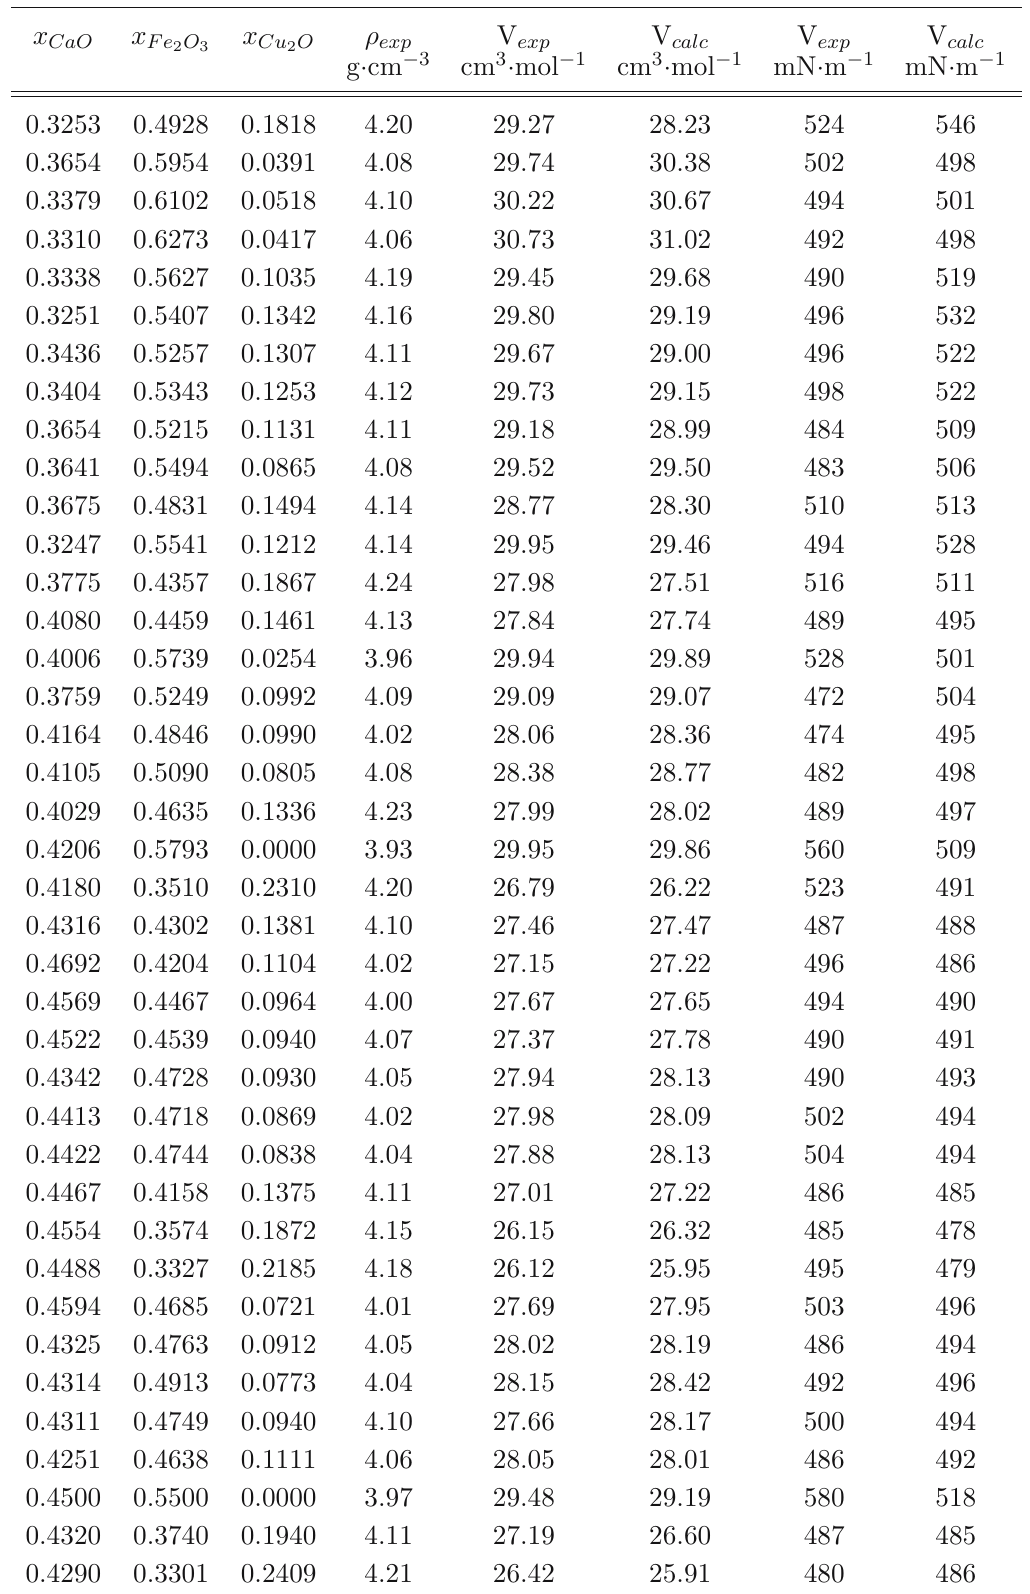
Table 3 Experimentally determined values of the density, molar volume and surface tension of the investigated melts of the system CaO-Fe 2 O 3 -Cu 2 O at the temperature of 1573